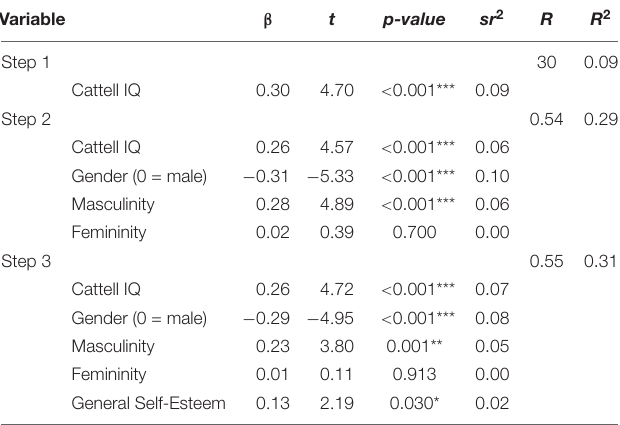
TABLE 3 | Hierarchical multiple regression of self-estimated intelligence scores ( N = 228).